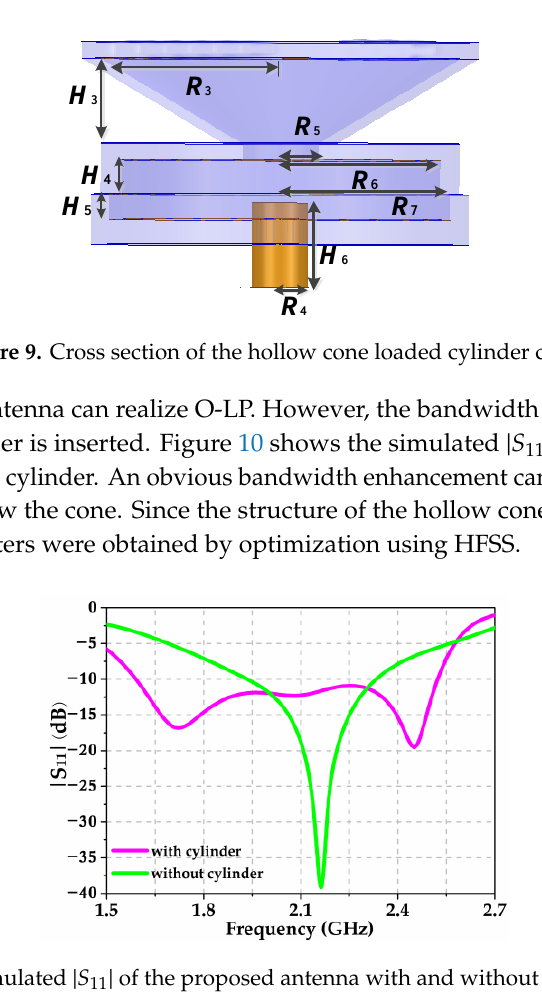
Electronics 2020 , 9 , 873 Figure 8. Diagram of State-II with liquid metal filled in. Figure 8. Diagram of State-II with liquid metal filled in.